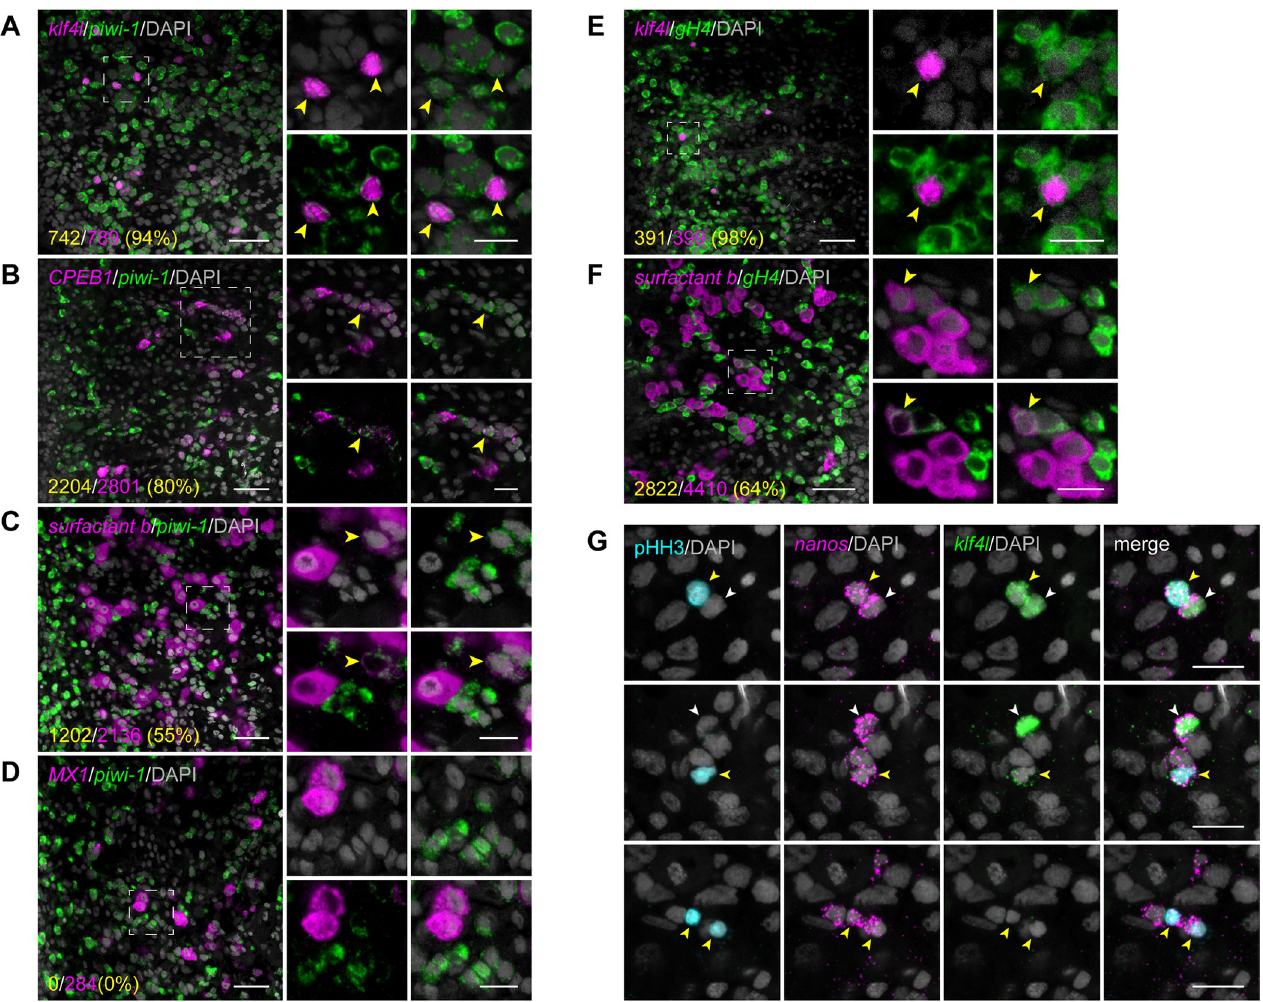
Fig 6. Yolk cells share features with neoblasts and germ cells. ( A–D ) Single confocal sections showing dFISH of neoblast and germ cell marker piwi-1 (green) and klf4l ( A ), CPEB1 ( B ), surfactant b ( C ), and MX1 ( D ) (magenta). Side panels are high-magnification views of outlined areas showing piwi-1 double-positive cells (yellow arrowheads). ( E, F ) Single confocal sections showing dFISH of neoblast and germ cell marker gH4 (green) and klf4l ( E ) and surfactant b ( F ) (magenta). Side panels are high-magnification views of outlined areas showing gH4 double-positive cells (yellow arrowheads). ( G ) Maximum intensity projections of confocal sections (5- μ m thick) imaged from the ventral posterior region of sexually mature planarians showing klf4l (green) and nanos (magenta) dFISH with pHH3 (cyan) immunostaining in vitellaria. Mitotically active klf4l + / nanos + vitellocytes with high (top panels) and low levels (middle panels) of klf4l expression are shown (yellow arrowheads). Nondividing klf4l + / nanos + cells are also present (white arrowheads). klf4l – / nanos + yolk cell progenitors are able to divide (bottom panels; yellow arrowheads). ( A–G ) Nuclei are counterstained with DAPI (gray). Scale bars, 50 μ m for overview images, 20 μ m for side panels ( A–F ), 20 μ m ( G ). Underlying data can be found in S1 Data. dFISH, double